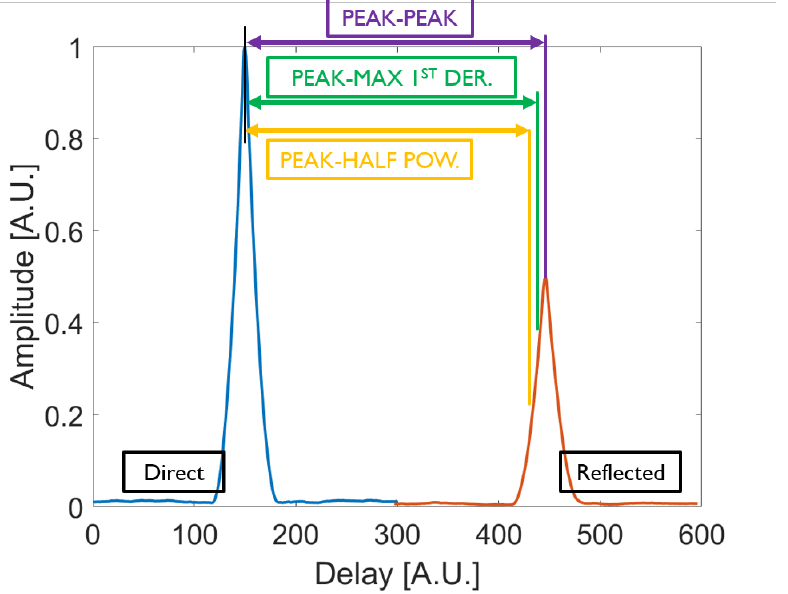
Figure 5. Diagram illustrating different methods to compute the time difference between the direct and the reflected correlations for the altimetry observable. P-P (purple), P-Max1D (green), and P-HP